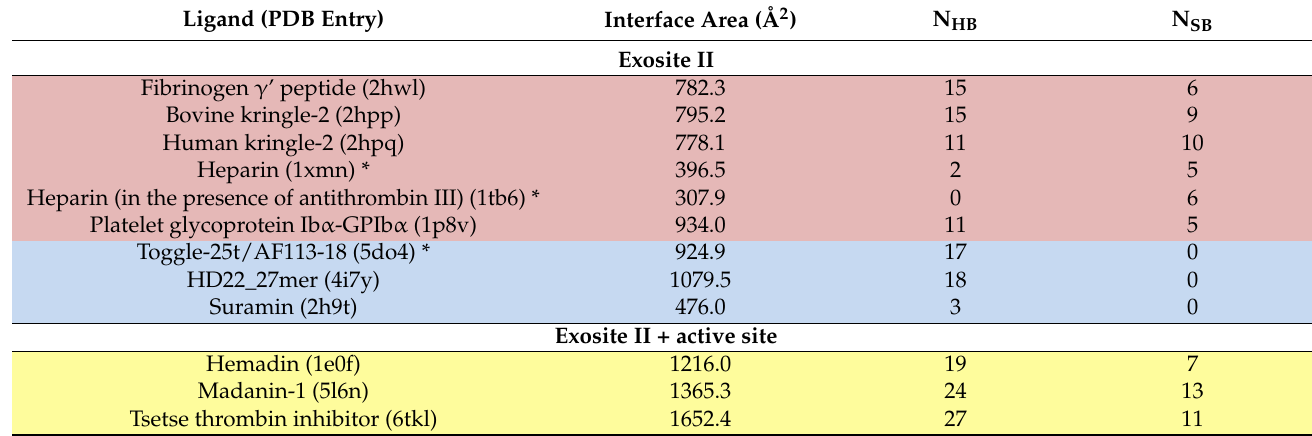
Table 5. Interaction data (interface area, number of H-bonds/salt bridges) detected in the crystallographic structures of thrombin complexes with ligands bound at exosite II or at both exosite II and active site. Functional partners, natural inhibitors, and synthetic compounds are highlighted in pink, yellow, and light blue, respectively. Analyses have been conducted using the PISA program